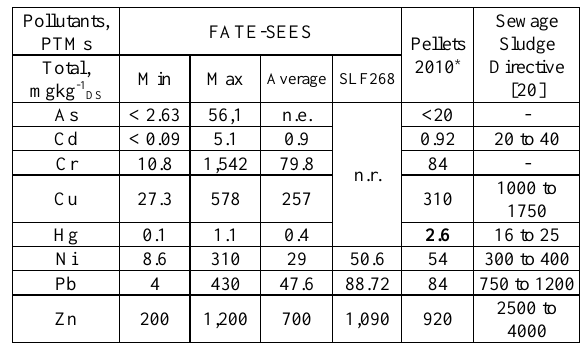
Table 9. Comparison of limit values for